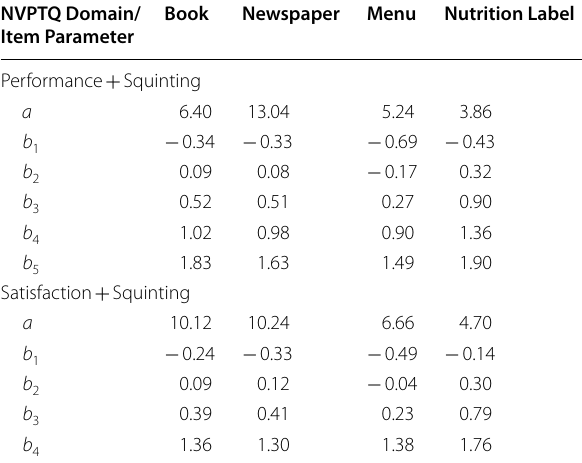
Data are from Day 28 Hour 1